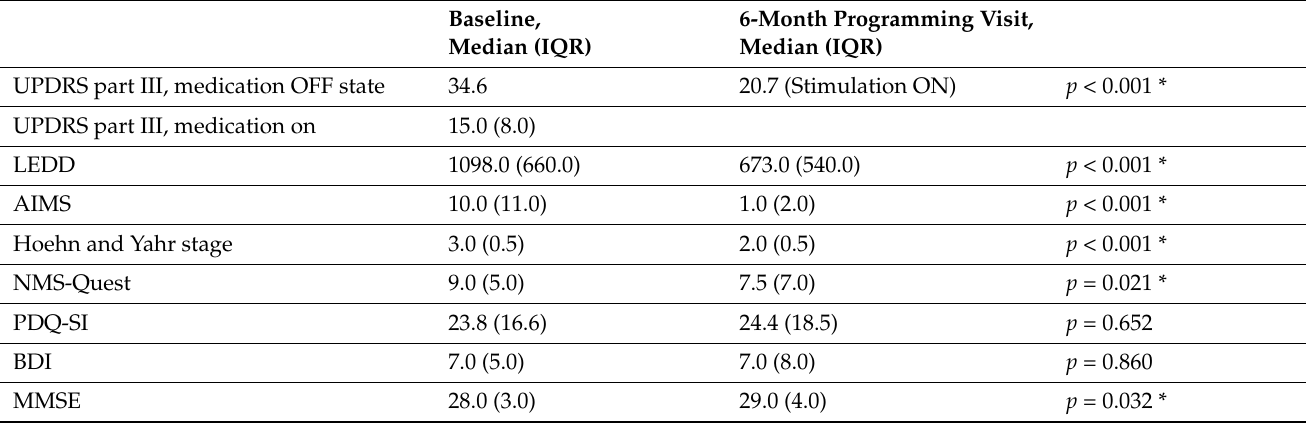
Table 2. Clinical results after the in-hospital six-month